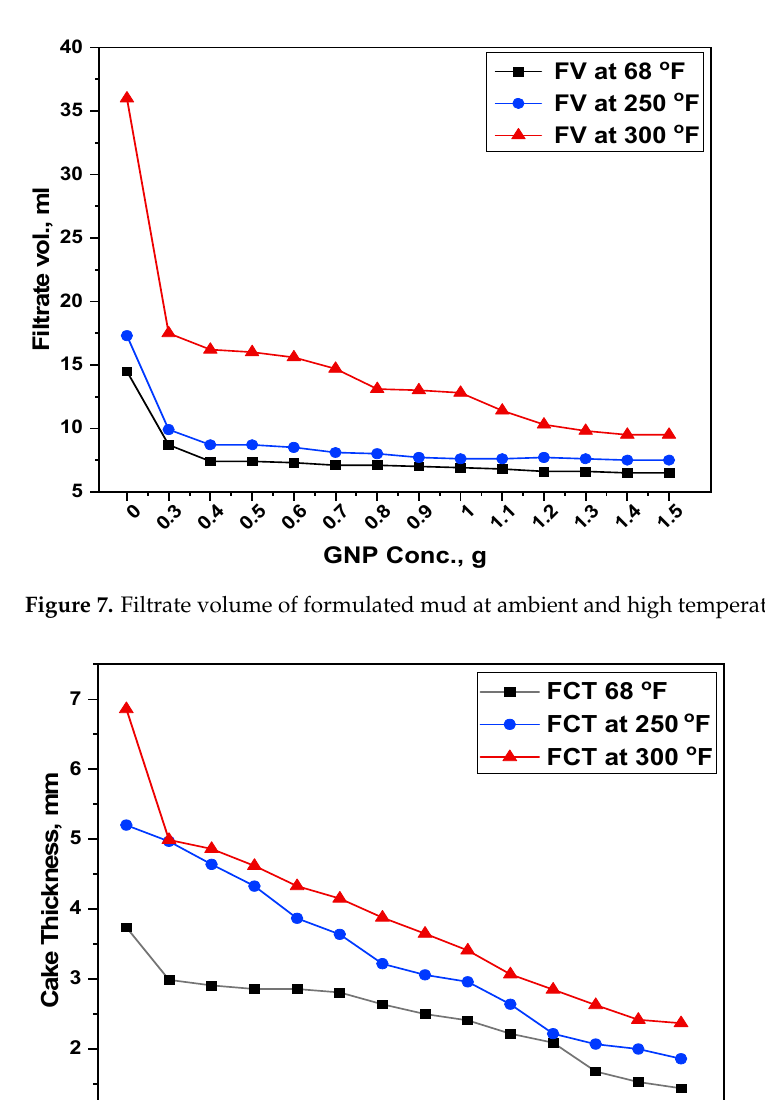
Figure 7. Filtrate volume of formulated mud at ambient and high temperatures.